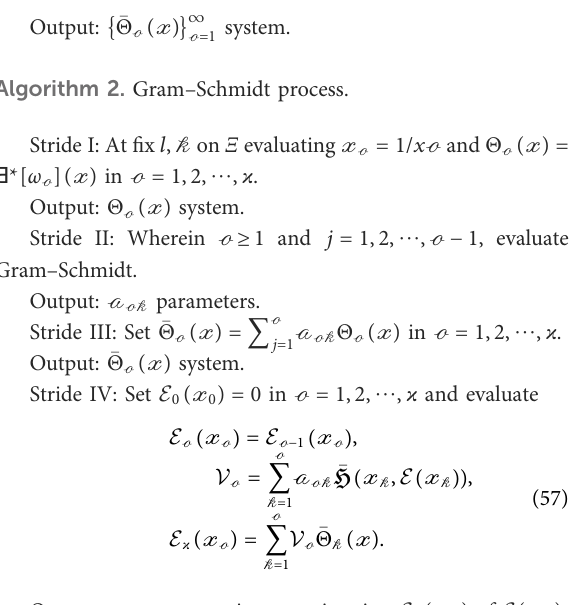
Algorithm 3. Process of RKHA solutions.